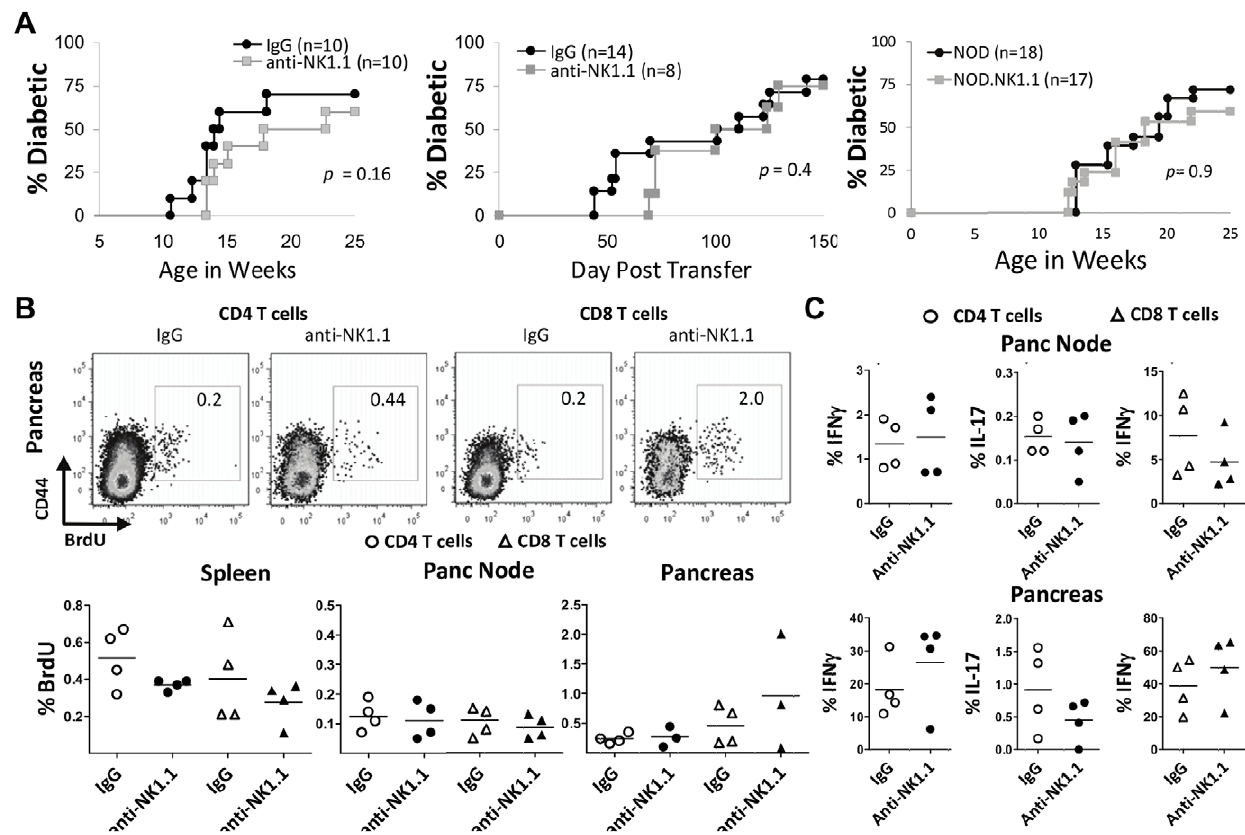
Figure 7. NK cells are not required for the progression to diabetes. A) The left panel shows the rate of spontaneous diabetes in NOD.NK1.1 littermates that received either anti-NK1.1 or an isotype-matched control IgG from 3 through 10 weeks of age (10 litters). In the middle panel, purified CD4 + T cells from diabetic NOD mice were transferred into Rag2 2 / 2 NOD.NK1.1 mice and treated with anti-NK1.1 or an isotype-matched control IgG. Both groups in the adoptive transfer experiments also received anti-CD8 to ensure exclusively CD4 + T cell-mediated disease. The far right panel shows the incidence of disease in unmanipulated NOD mice and NOD.NK1.1 mice in our colony. P values were calculated using the Mann-Whitney U test. B) Five hundred micrograms of BrdU was in injected intravenously and mice were sacrificed one hour later. Flow cytometric plots of cells isolated from the pancreas from one representative experiment are shown. Graphs are cumulative of 3 independent experiments involving littermates. C) NOD.NK1.1 mice were sacrificed after 10 weeks after receiving noted treatment regimens. Isolated leukocytes from the pancreatic lymph node or pancreas with stimulation with PMA and ionomycin for 3 hours in the presence of GolgiStop and assayed for intracellular IFN c or IL-17 production by CD4 + T cells or CD8 + T cells, as indicated. Graphs are cumulative of 3 independent experiments involving littermates. No significant difference between groups was demonstrated in any parameter assayed.